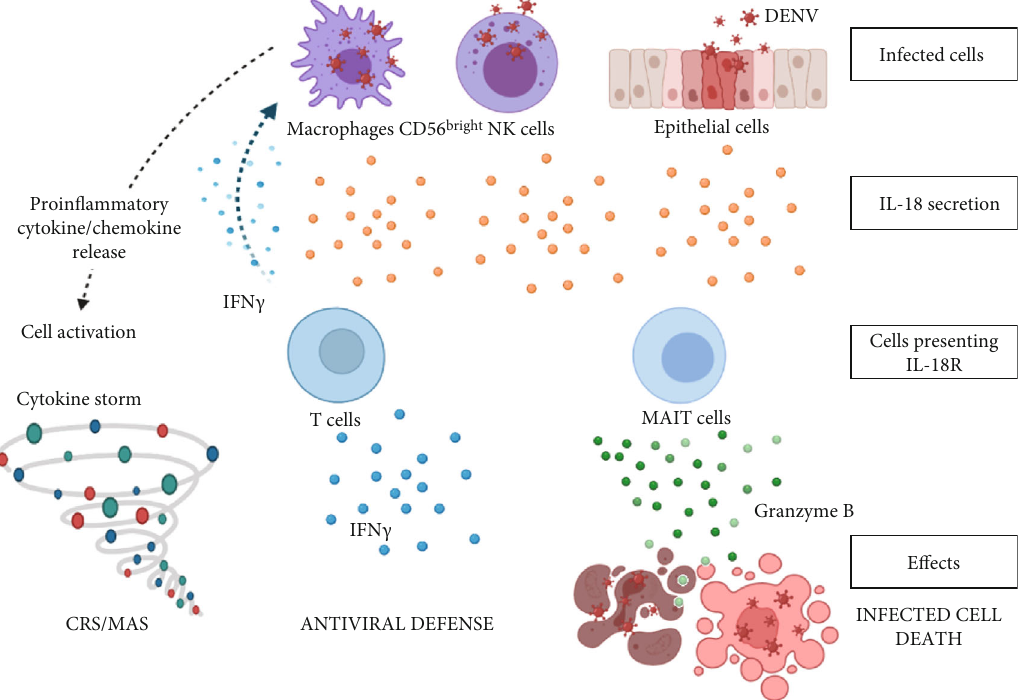
Figure 2: The actions of IL-18 in host immune responses to DENV